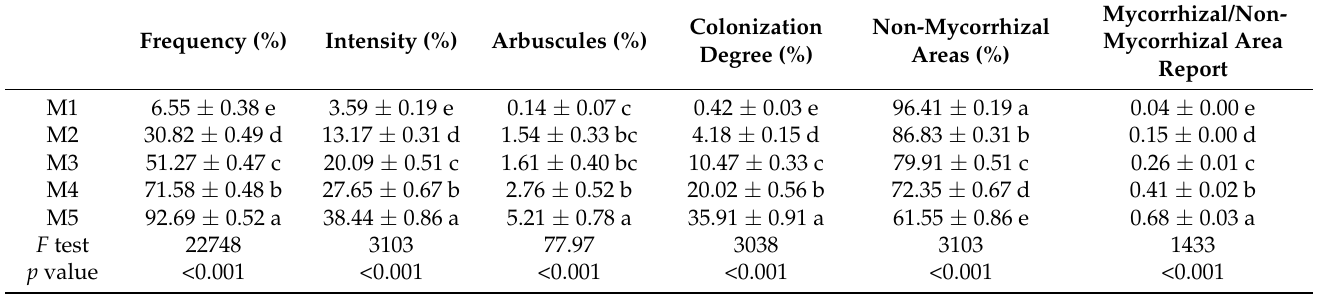
Table 1. Dynamics of colonization parameters in Festuca rubra